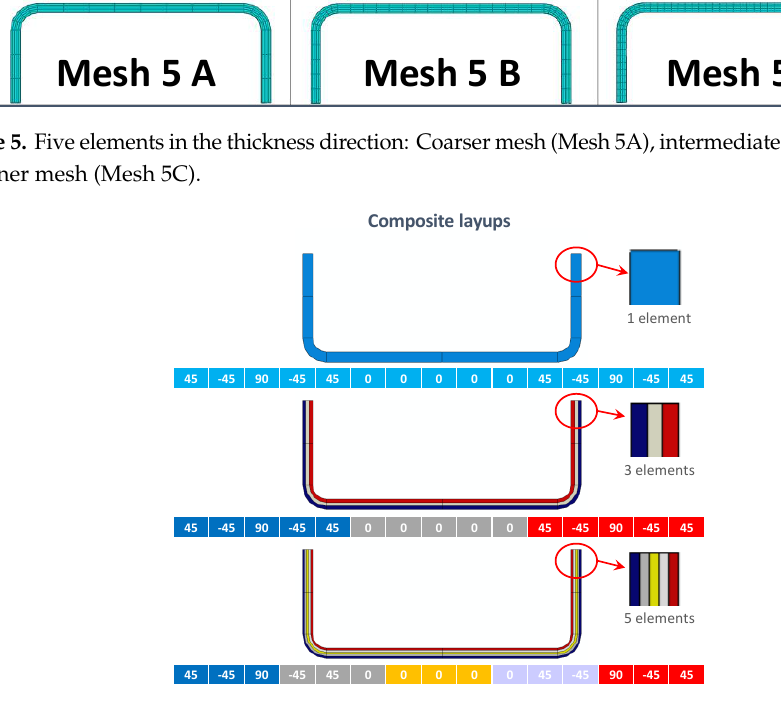
Figure 6. Composite layups.